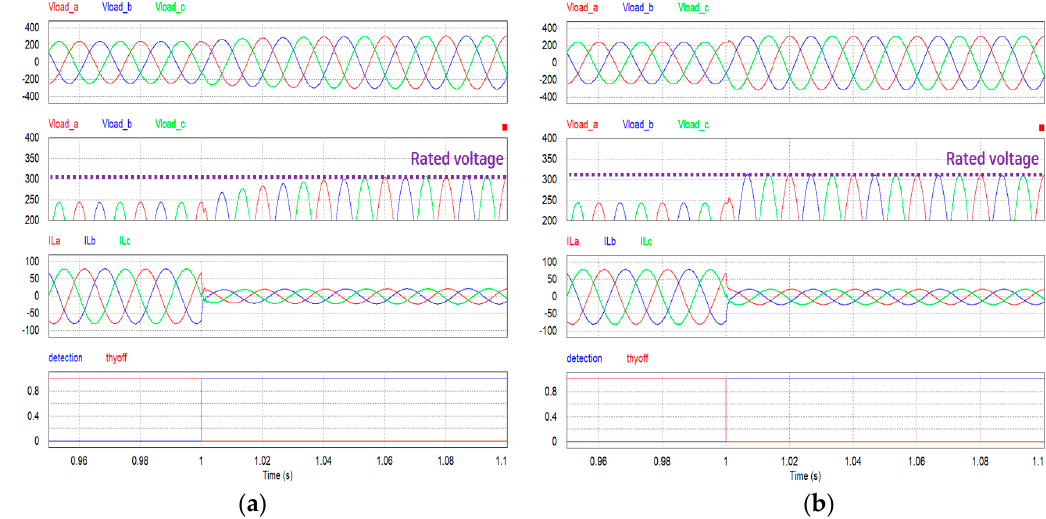
Figure 12. Simulation results of mode switching in the case of low-grid voltage during renewable energy generation: ( a ) using the general inverter controller; ( b ) using the proposed load current compensation controller.